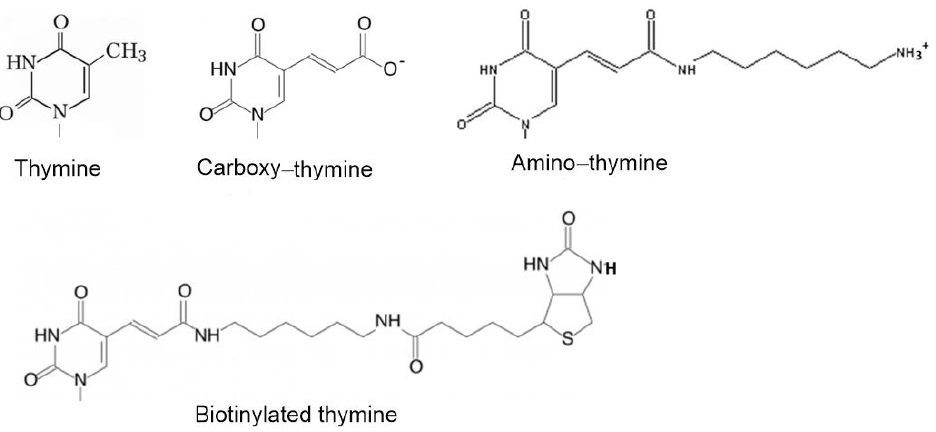
Figure 3. Modifications of thymines chosen for experimental verification of the energy dissipation hypothesis. Table 2. The sequences of HD1 and its modifications. The structures of modified nucleotides are provided in Figure 3.